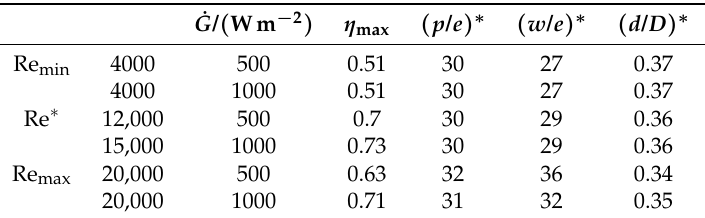
Table 9. Maximum efficiency and optimum roughness parameters according to the model developed by Bhushan and Singh